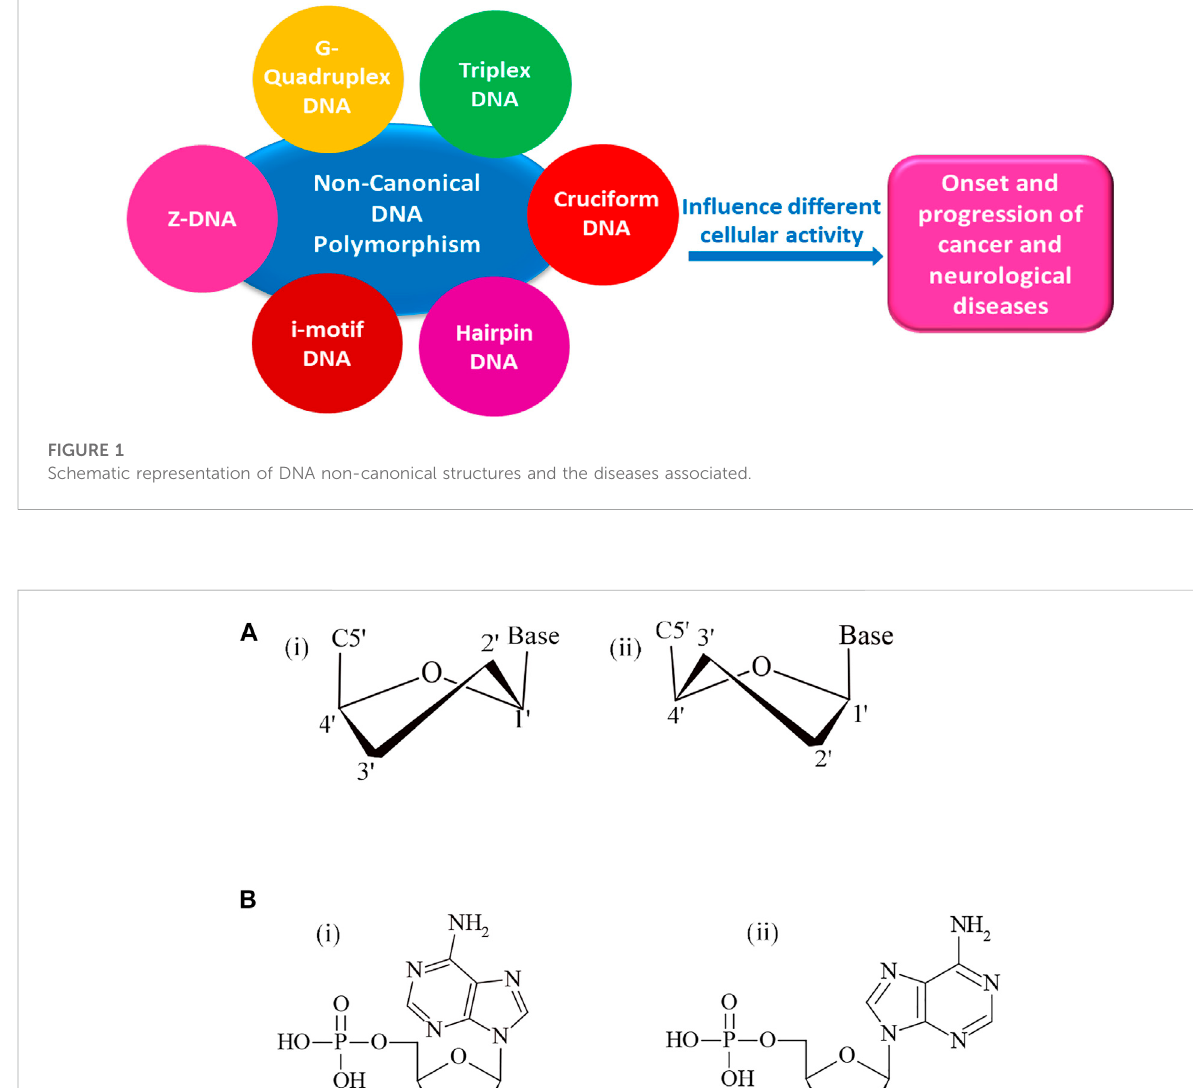
ligand, etc. A-DNA and B-DNA are the most commonly studied form of DNA but other non-canonical structures like Z-DNA, hairpin/cruciform, triplex, G-quadruplex, and i-motif are also well established as given in Figure 1 (Pandya et al., 2021). The topological diversity of DNA is also attributed to various sugar and backbone conformational variables, the directionality of the glycosidic bonds and steric extensions, along with different base- pairing elasticities (Kaushik et al., 2011). In the right-handed B-DNA, the sugar-base linkage (N-glycosidic bond) is normally